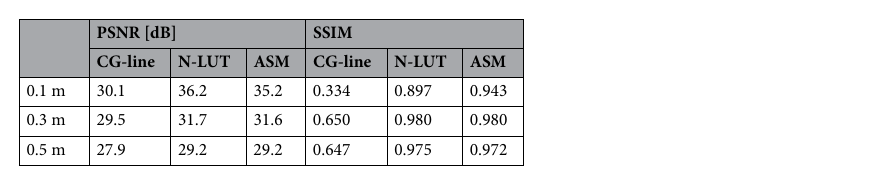
Table 2. Average PSNR and SSIM for all